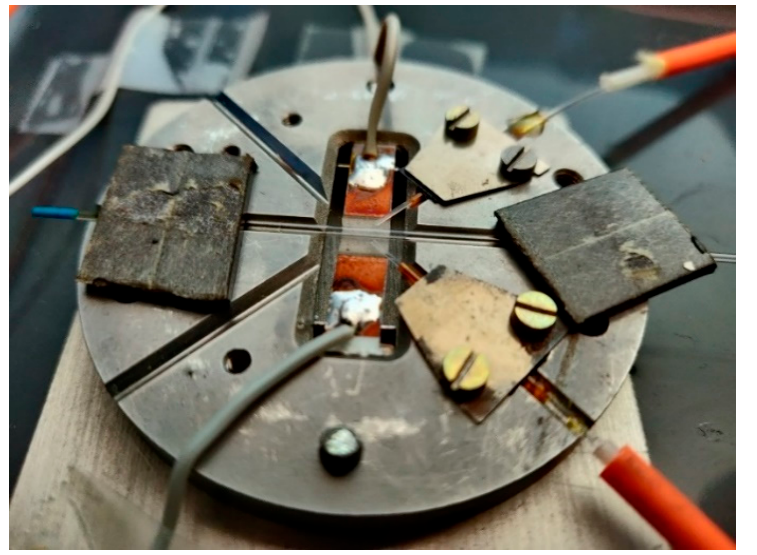
Figure 8. The view of house-made head.